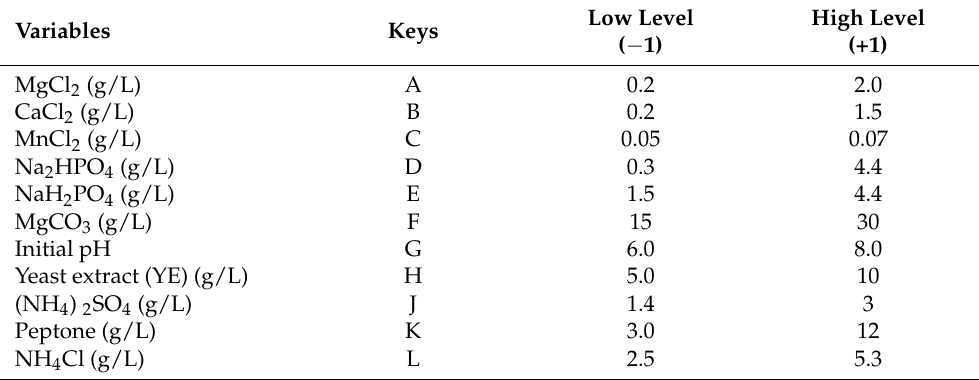
Table 1. Experimental definition for PBD for succinic acid production by E. gallinarum